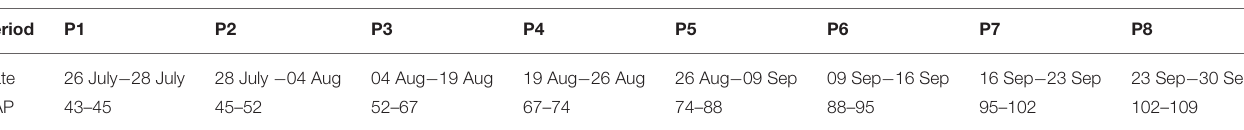
TABLE 1 | Summary of data collection dates (Year: